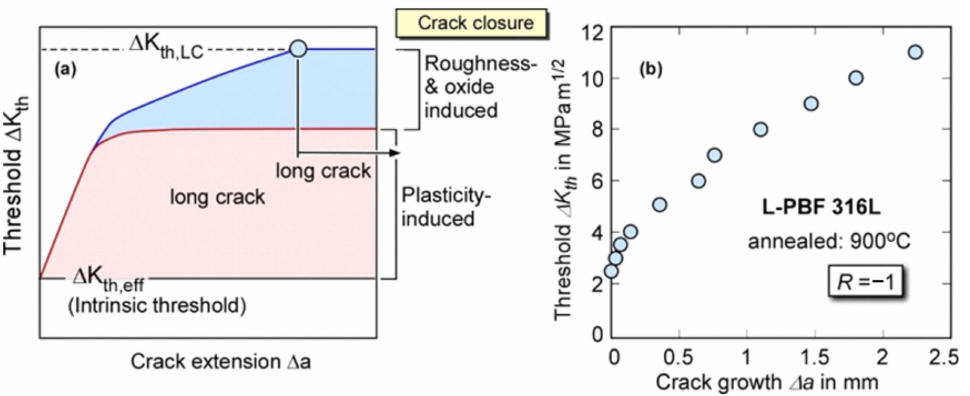
Figure 9. Cyclic R curve: ( a ) schematic view, including the effect of the crack closure effects on ∆ K th , op ; ( b ) example of a curve for L-PBF steel 316L (Werner, T., BAM Berlin, 2020).